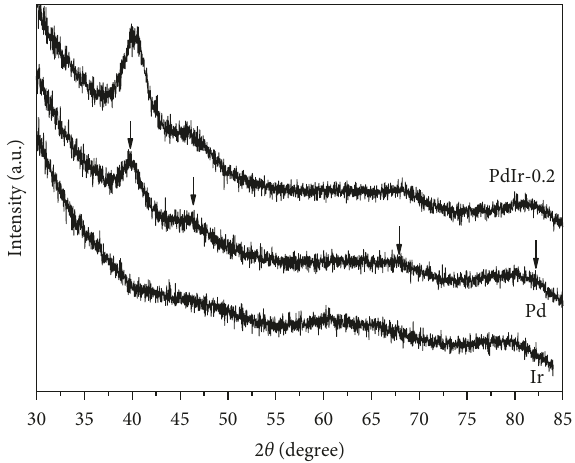
Figure 1: XRD diffraction patterns of Ir/SiO 0.2/SiO 2 .